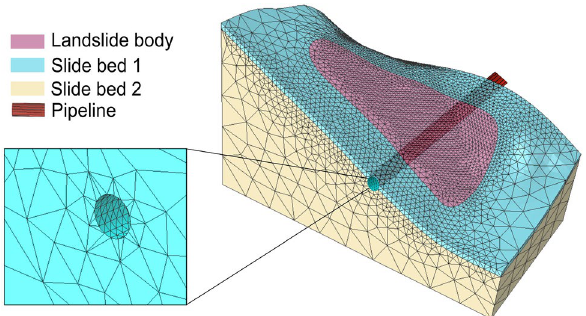
Fig. 4 A finite element pipe-soil coupling model established for the Xinzhan landslide